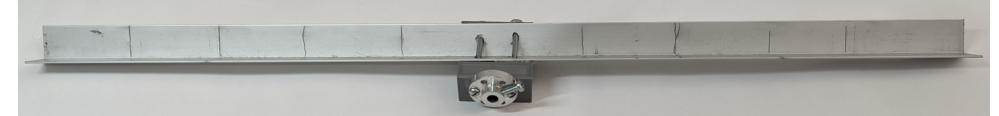
Figure 2. Final assembly of the coupling on the rail using one of the 3D-printed parts.